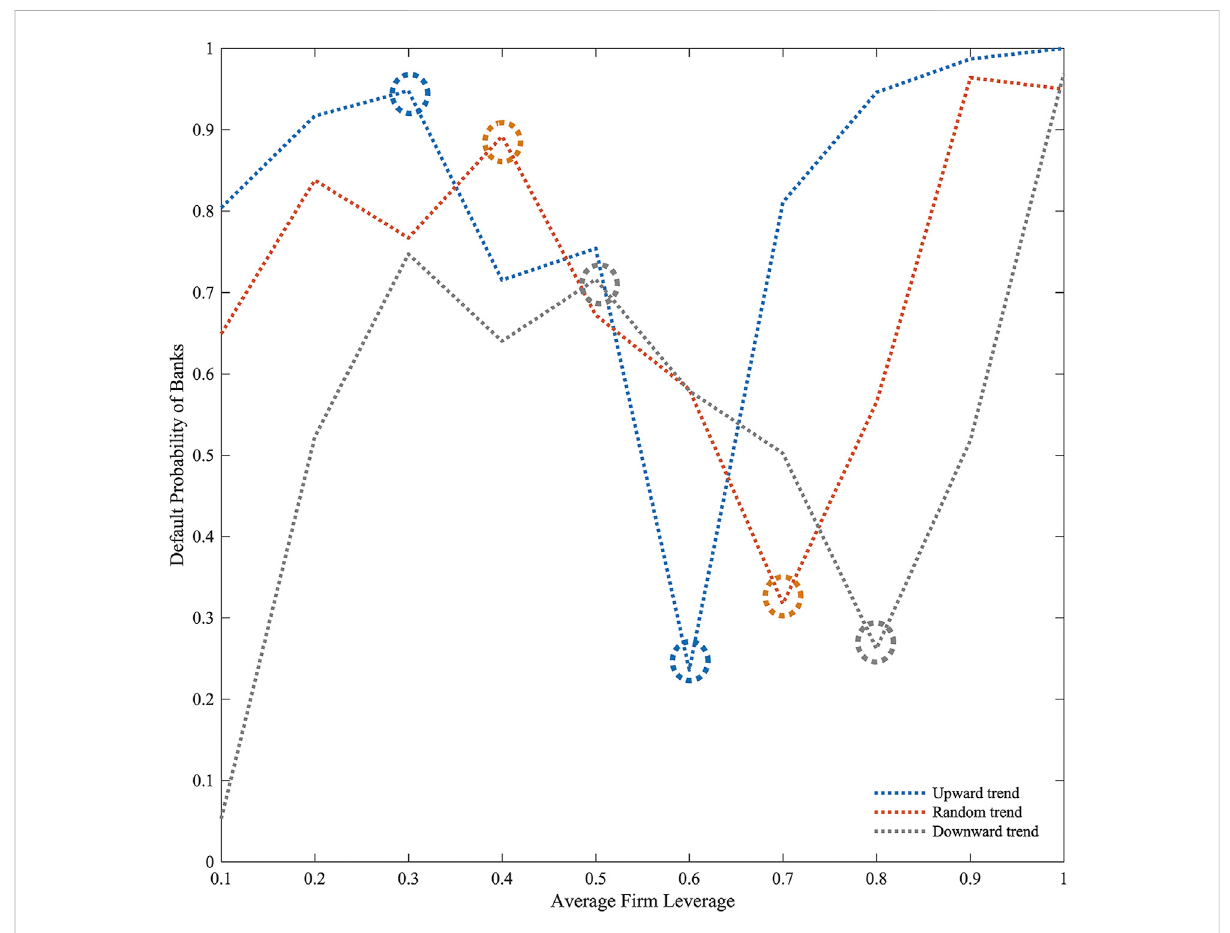
FIGURE 8 The default probability of banks with different average fi rm